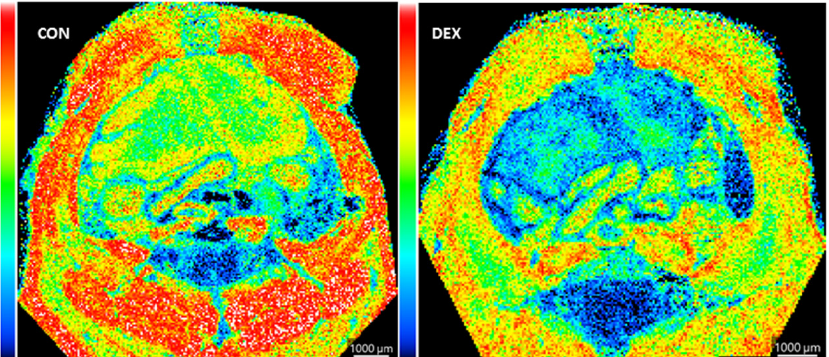
Figure 4. MSI derived from purine and pyrimidine metabolites. Panel ( a – c , g – i ) are from control mouse and ( d – f , j – l ) are from DEX-treated mouse. AMP: ( g , j ); ADP: ( h , k ); ATP: ( i ) and ( l ). UMP: ( a ) and ( d ); UDP: ( b , e ); UTP: ( c , f ). Color scale for adenine nucleotides are between 0 and 53.989% ( g – l ) and for uridine nucleotides are between 0 and 60.628% ( a – f ), respectively.